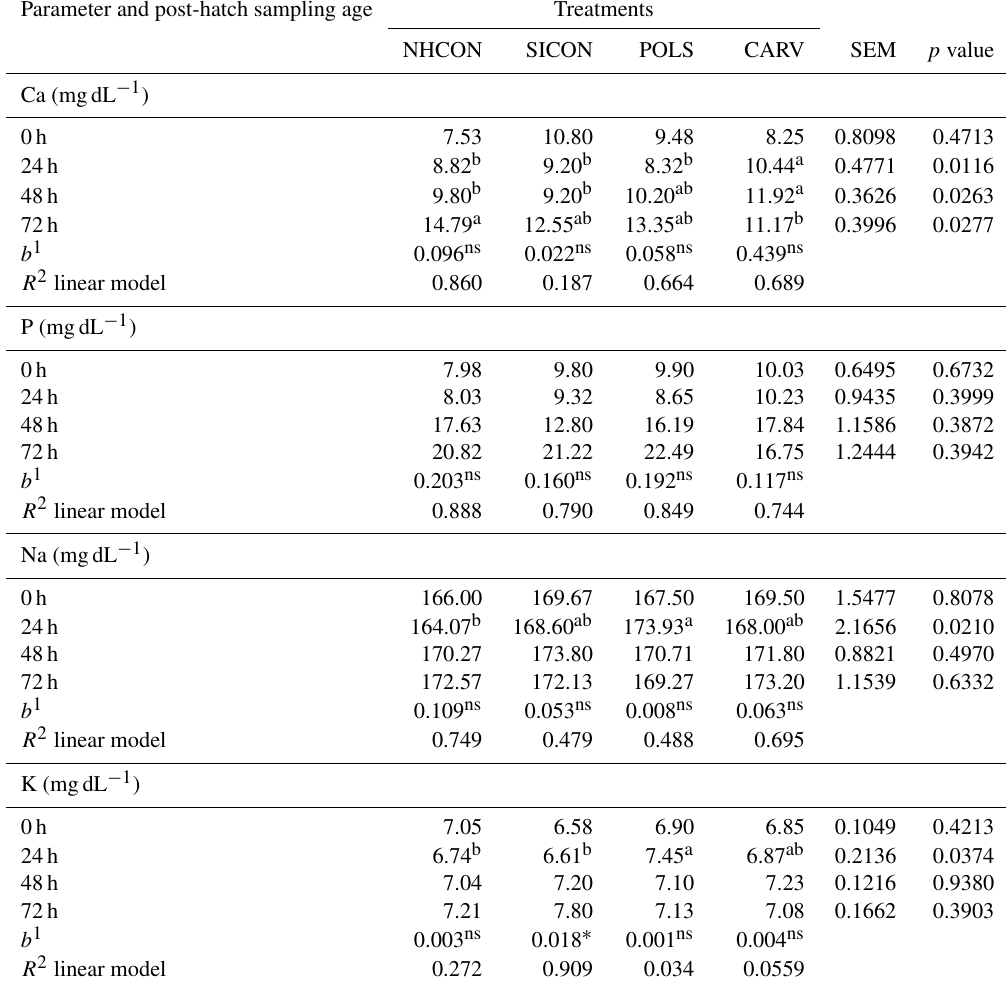
Table 5. Blood electrolyte concentrations in chicks subjected to experimental treatments, namely non-handled control (NHCON), sham injection control (SICON), polysorbate-80 injection (POLS), and carvacrol injection (CARV), in post-hatch sampling